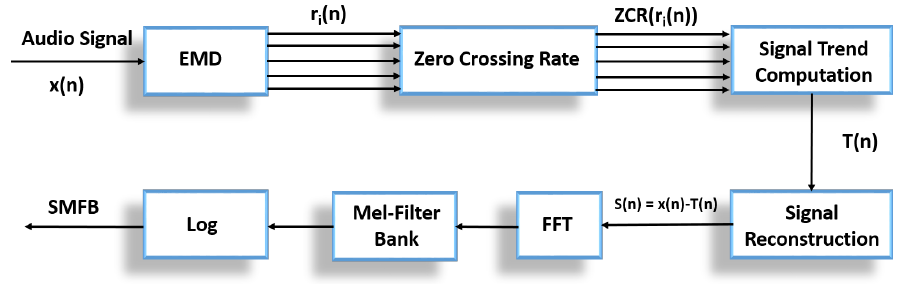
Figure 6. SMBE feature extraction block